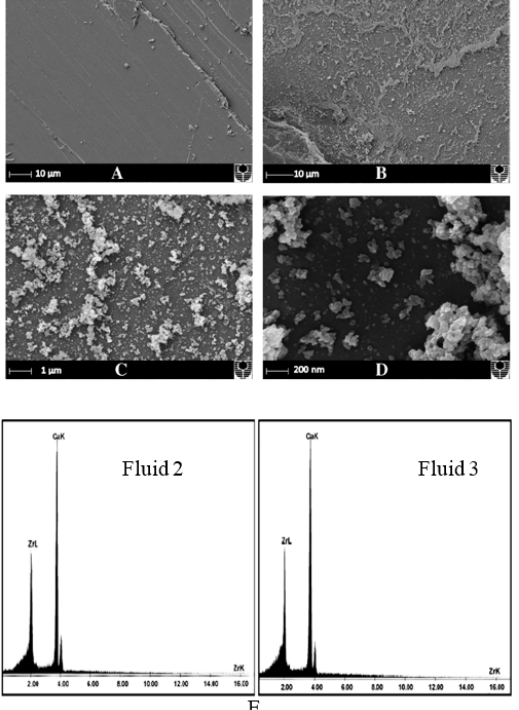
Figure 10. SEM images of the measured calcite surface: ( A ) before; ( B ) after nano-modification; ( C ) high resolution; and ( D ) maximum resolution; ( E ) EDX analysis of carbonate rocks aged in fluids [28].